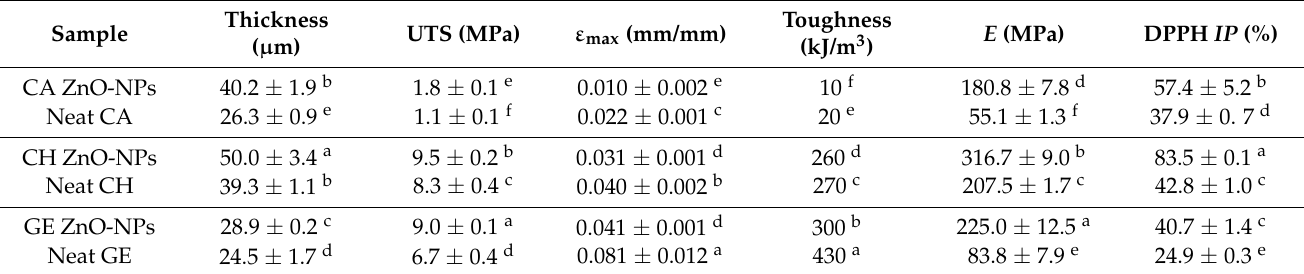
Table 2. Results for thicknesses, mechanical parameters (UTS, ε max , toughness and E ), and DPPH inhibition IP (%) of the different films reinforced with ZnO-NPs (1.0% w / w ) (CA-based, CH-based, and GE-based film ZnO-NPs). Neat films without ZnO-NPs (CA-based, CH-based, and GE-based neat films) were added as reference. The same superscript letters (a–f) in each column indicate homogeneity of variances ( p < 0.05).